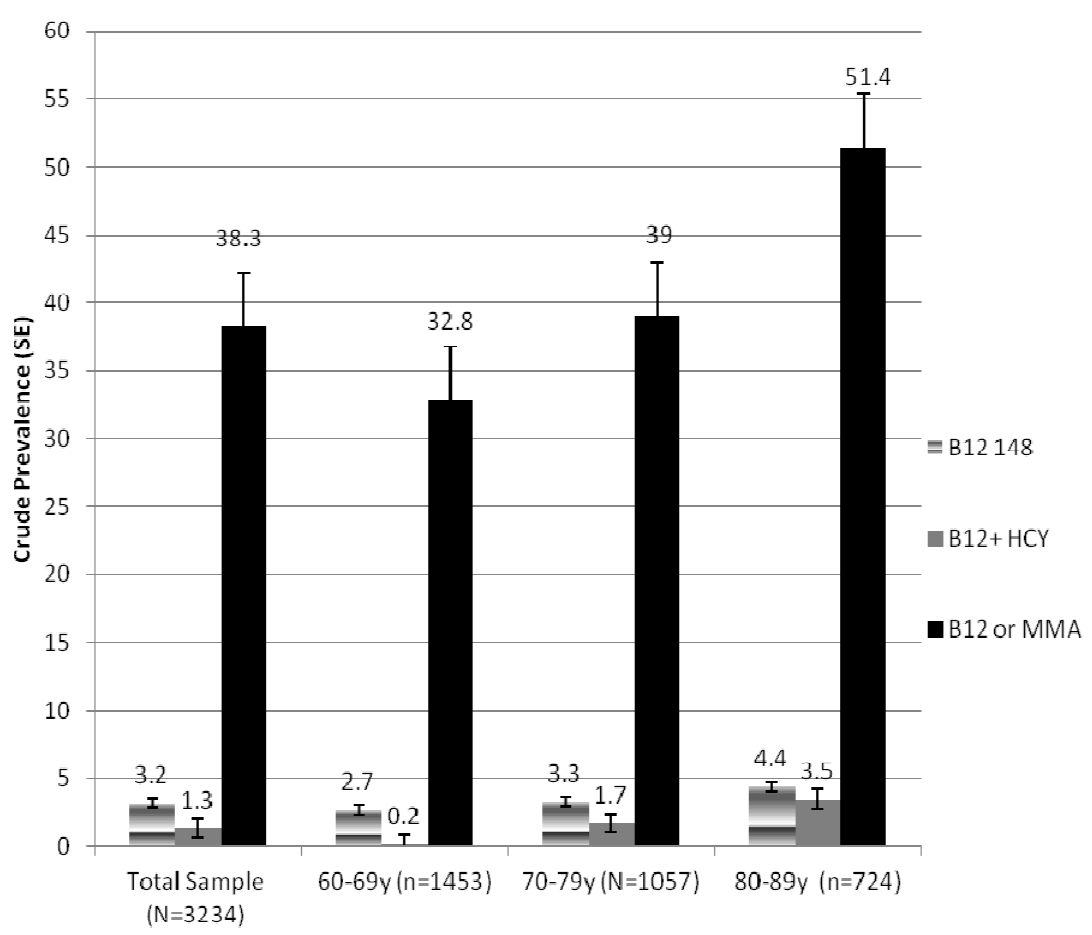
Figure 1. Crude (unadjusted) prevalence of vitamin B12 deficiency for the total population and by age decile based on three definitions of deficiency. Bars from left to right: serum B12 < 148 pmol/L alone ( gradient ); definition 2, serum B12 < 200 pmol/L and homocysteine > 20 μ mol/L ( solid gray ) and; the definition 3, serum B12 < 258 pmol/L or MMA > 0.21 μ mol/L ( solid black